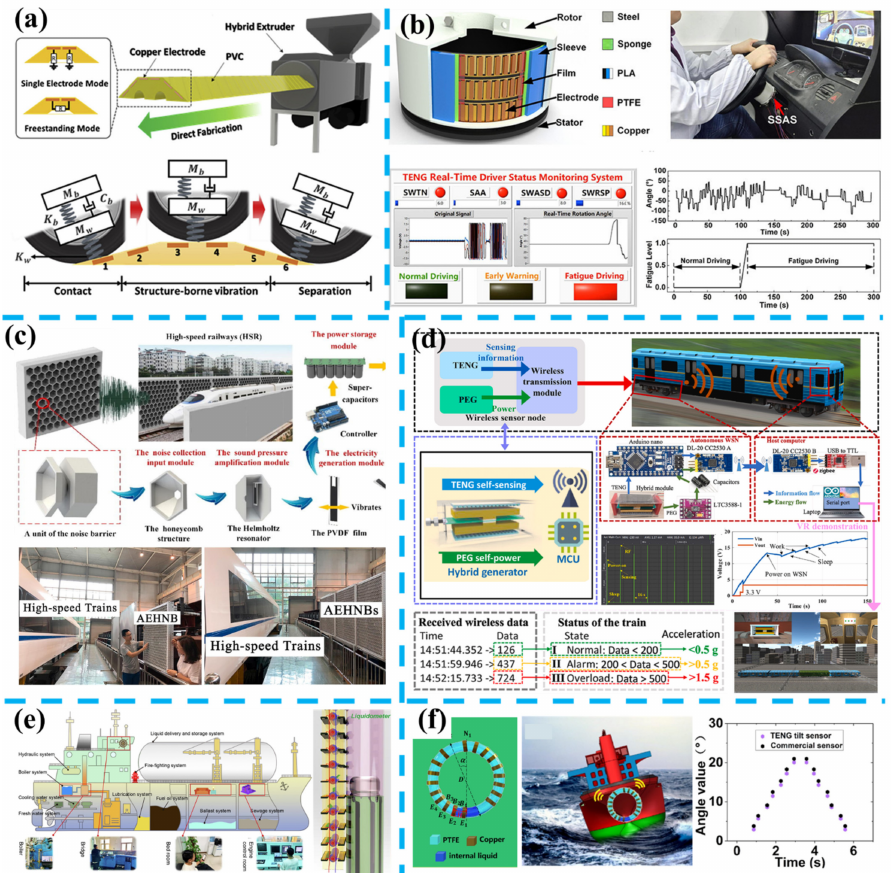
Figure 8. Transportation. ( a ) Triboelectric speed bump as a self-powered automobile warning